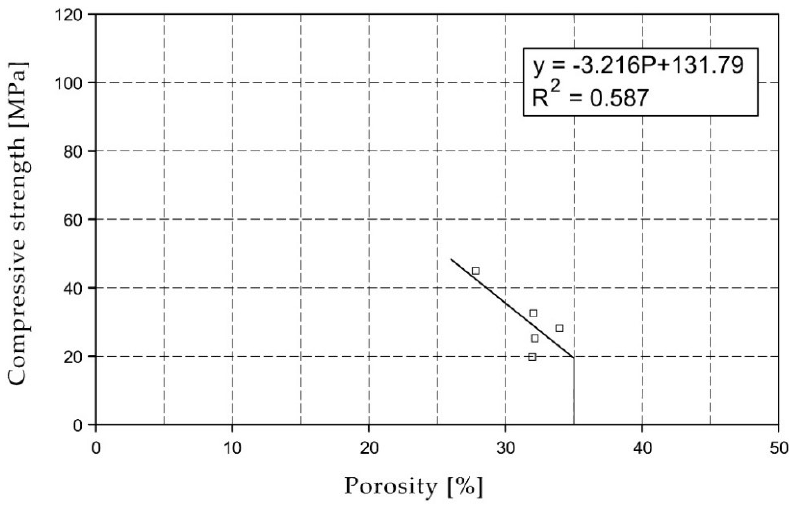
Figure 6. Compressive strength of O01XX series bricks.